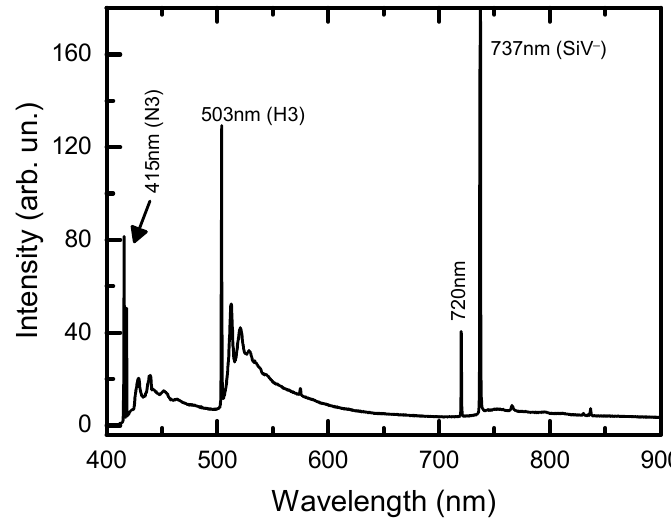
Figure 8. Typical PL spectrum of diamond crystals synthesized with 30 wt % of Sm 2 O 3 additives. PL was excited with a 395 nm laser.